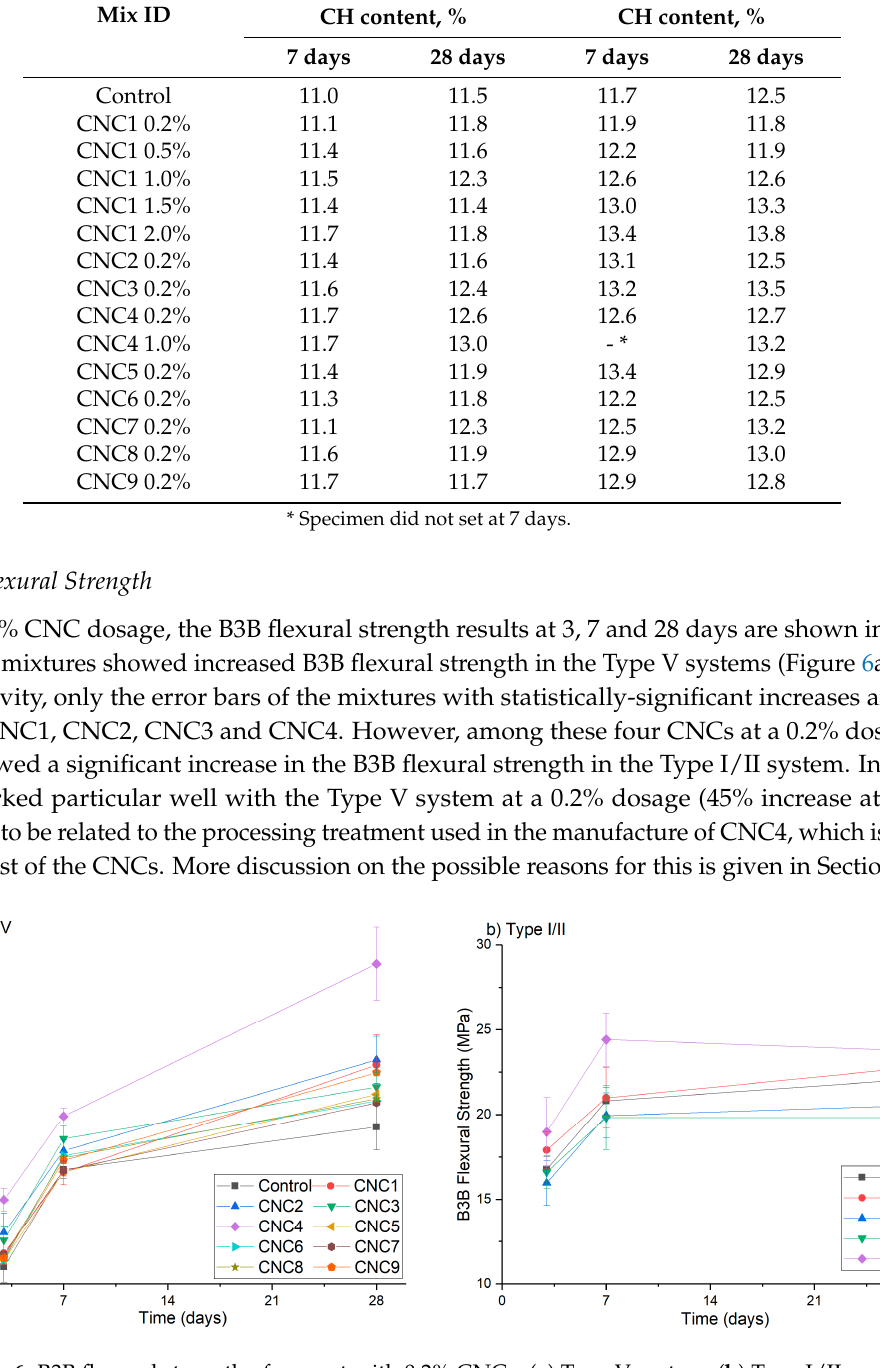
Figure 6. B3B flexural strength of cement with 0.2% CNCs: ( a ) Type V system; ( b ) Type I/II system.